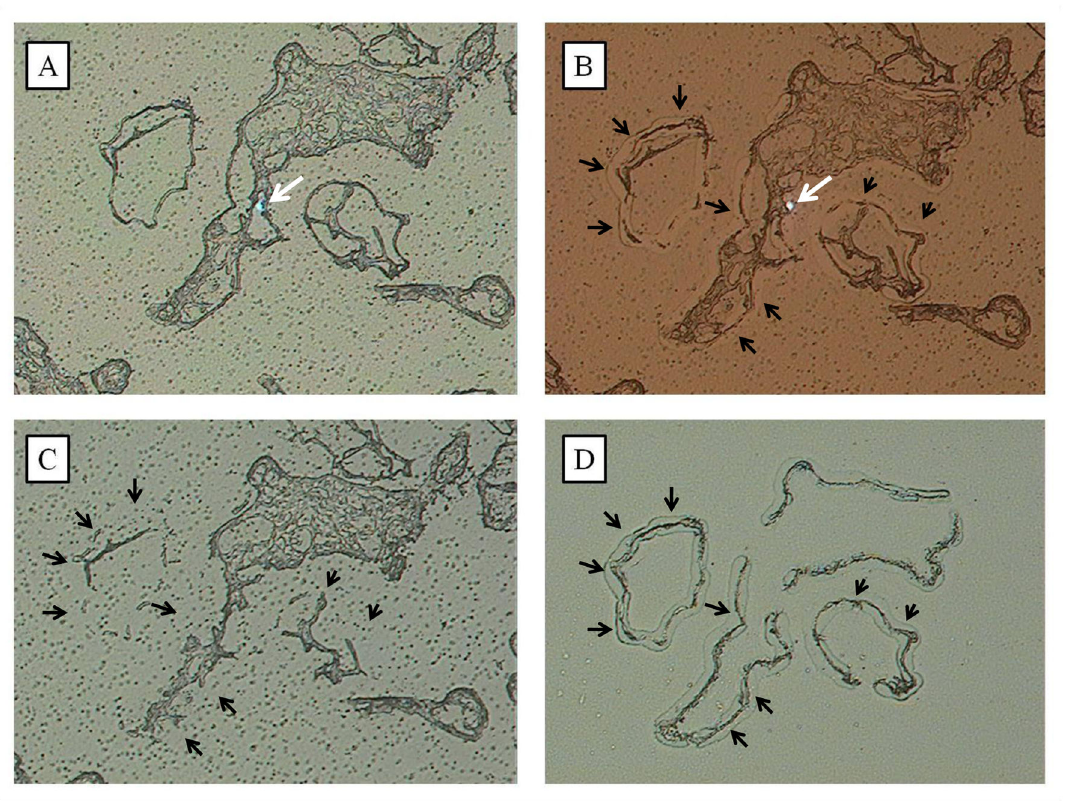
Figure 2. Process of laser capture microdissection. A, B, and C are sections of normal term placenta shown under laser capture microscope. A is a photograph showing chorionic villi with a laser spot (white arrow) in the middle. B is the same area showing trophoblasts (black arrows) affixed to the capture film by a laser pulse. C is the same area showing tissue left behind on the slide after laser capture of the trophoblast cells. D is an image of the cap with transfer film that was affixed to the trophoblasts (black